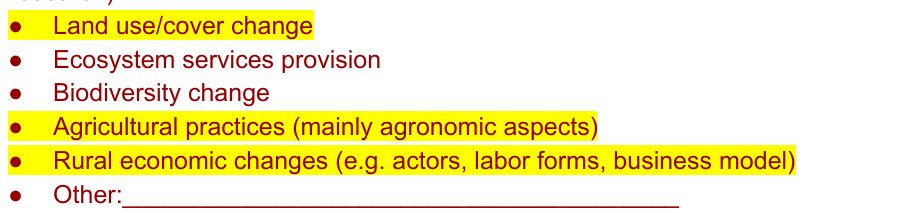
The following color coding indicates the style of answer expected for each of the points in the